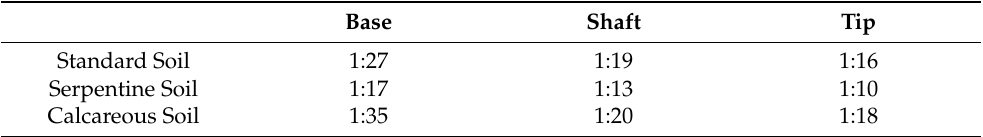
Table A1. Comparison of the Mg:Ca-ratios at the base, shaft and tip of analyzed trichomes. Ratios are based on peak height ratios pooled across taxa and separated based on soil type.